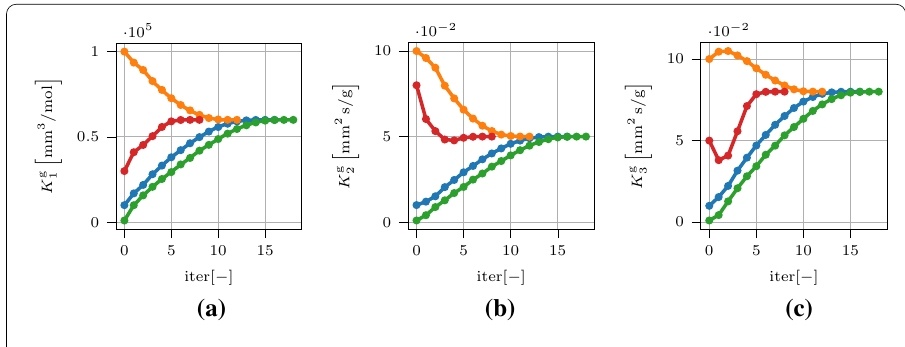
, b K g , c K g 1 2 3